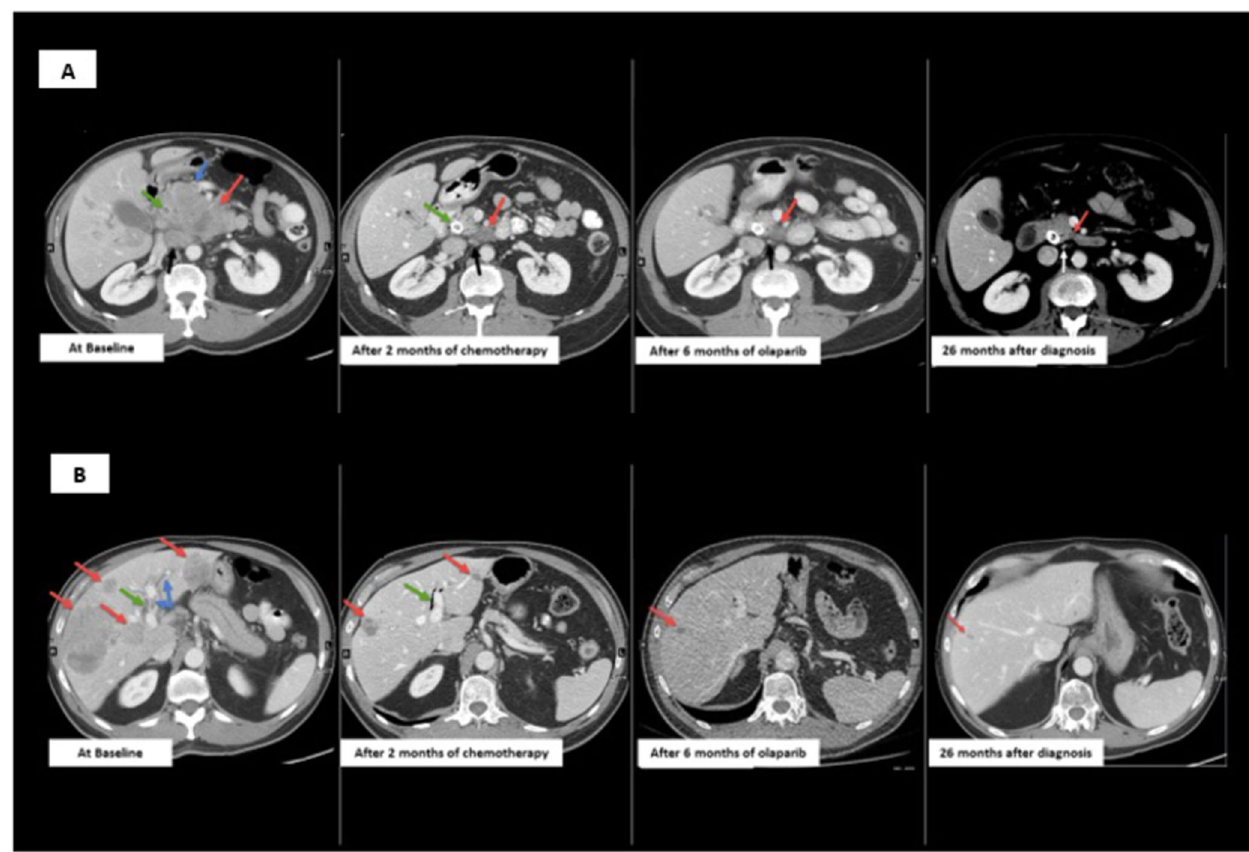
Fig. 1 Computed Tomography (CT) demonstrating responses to therapy. A CT abdomen with contrast through the pancreas. At Baseline, pre-treatment CT shows pancreatic head mass (red arrow) invading the superior mesenteric vein (blue arrow) and obstructing the common bile duct (green arrow). Enlarged aortocaval adenopathy (black arrow). After 2 months of platinum-based chemotherapy, CT shows markedly decreased pancreatic tumor (red arrow) and aortocaval adenopathy (black arrow), and placement of metal common bile duct stent (green arrow). After 6 months of Olaparib, CT demonstrates further reduction in pancreatic tumor (red arrow) and aortocaval adenopathy (white arrow). 26 months after diagnosis, CT demonstrates ongoing response to PARPi in pancreatic tumor (red arrow) and aortocaval adenopathy (white arrow). B CT abdomen with contrast through the liver. At baseline, pre-treatment CT shows multiple bilobar liver metastases (red arrows), portal vein bland thrombus (blue arrows) and dilated intrahepatic bile duct (green arrow). After 2 months of platinum-based chemotherapy, CT shows resolved and markedly decreased liver metastases (red arrows), resolved portal vein thrombus and new pneumobilia (green arrow) from metal common bile duct stent placement (not shown). After 6 months of Olaparib, CT demonstrates further reduction of liver metastases (red arrow). 26 months after diagnosis, CT demonstrates ongoing response of liver metastases (red arrow) to PARPi. *PARPi poly (ADP-ribose) polymerase